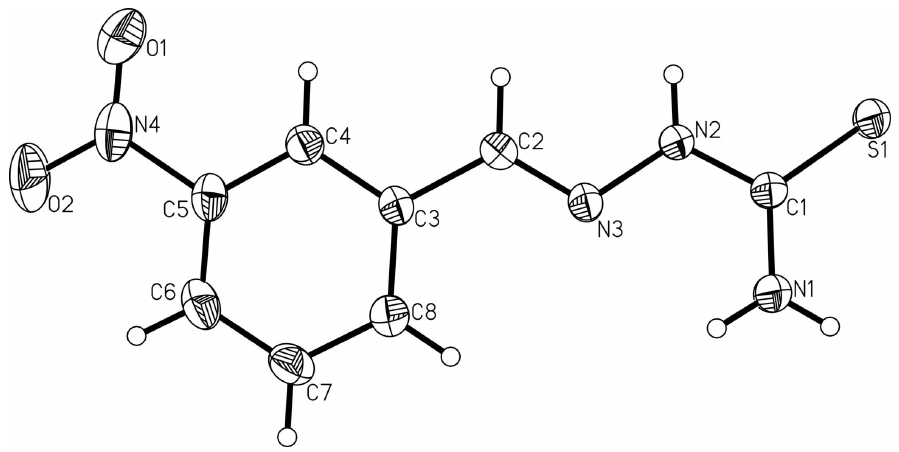
Figure 1 The molecular structure of the title compound, showing the atomic numbering scheme. Displacement ellipsoids are drawn at the 30% probability